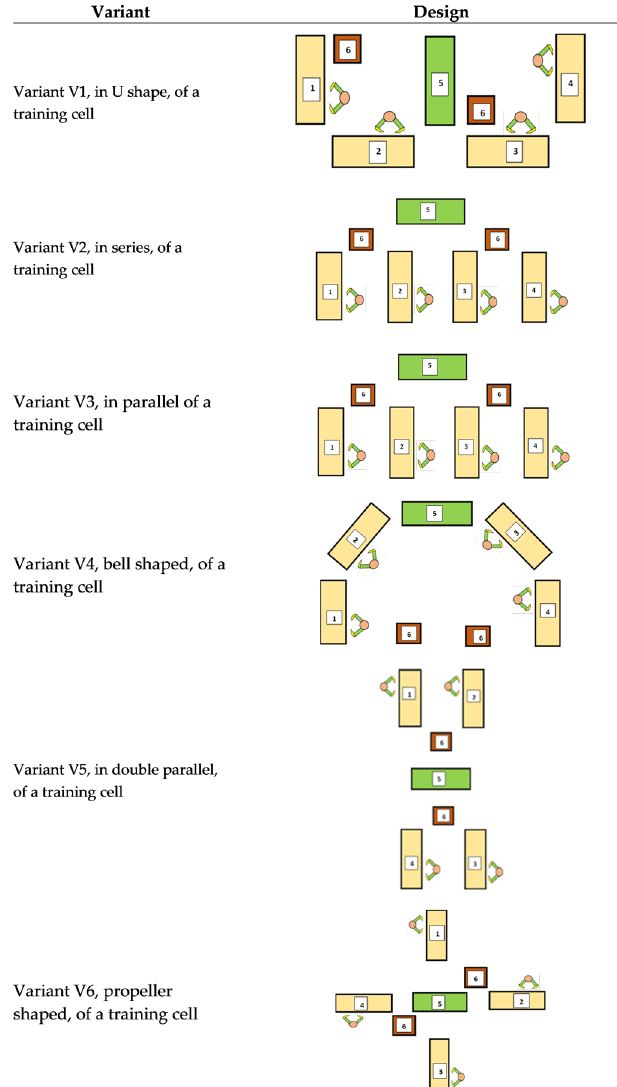
Figure 6. V1–V6 training configuration, where: 1, 2, 3, 4—Work modules; 5—Control module; 6—Mobile transport modules to the control module.